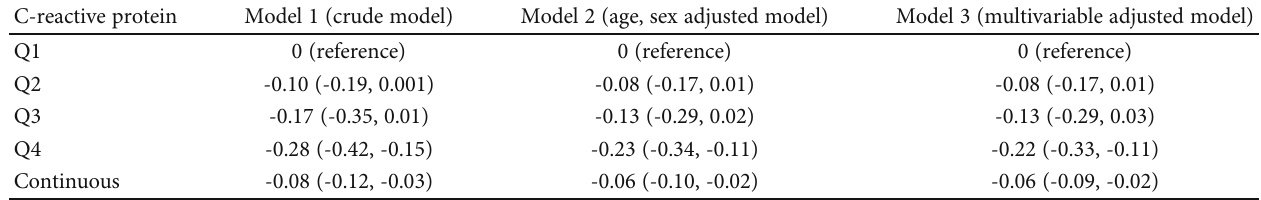
Table 3: Association between C-reactive protein and telomere length in NHANES.